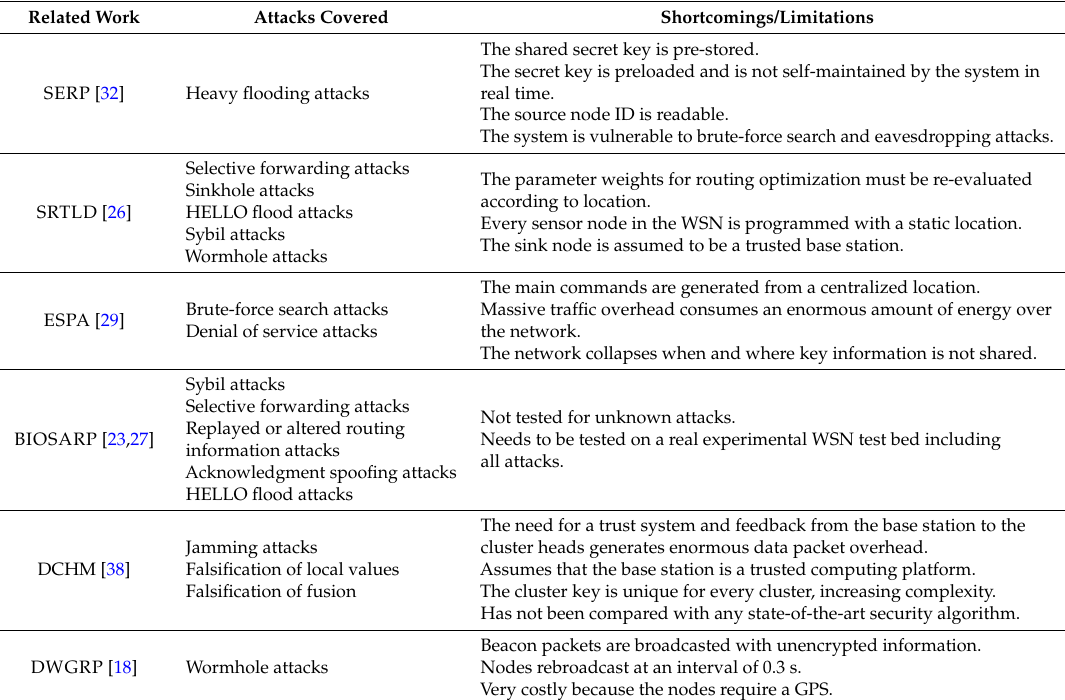
Table 1. Comparison of recent routing protocols for WSN